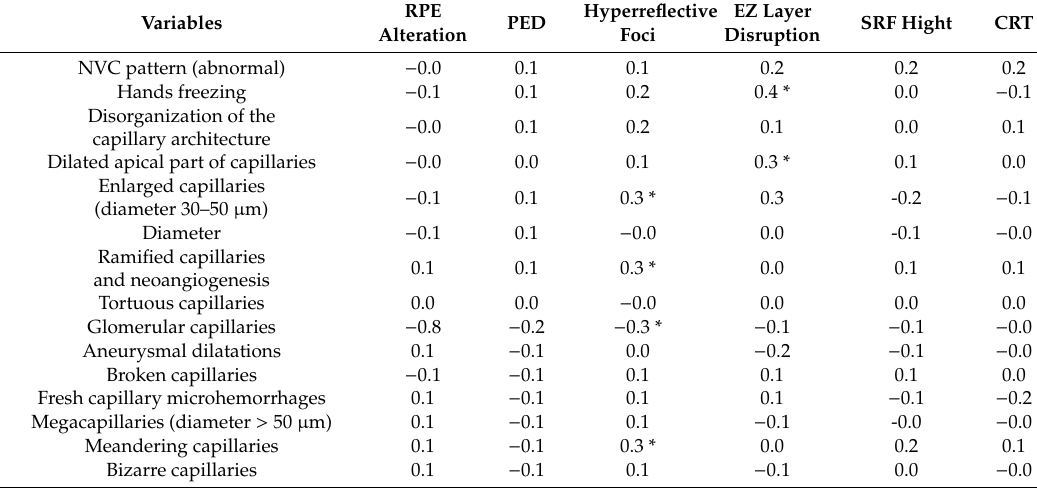
Table 3. Correlation between NVC parameters and OCT results.